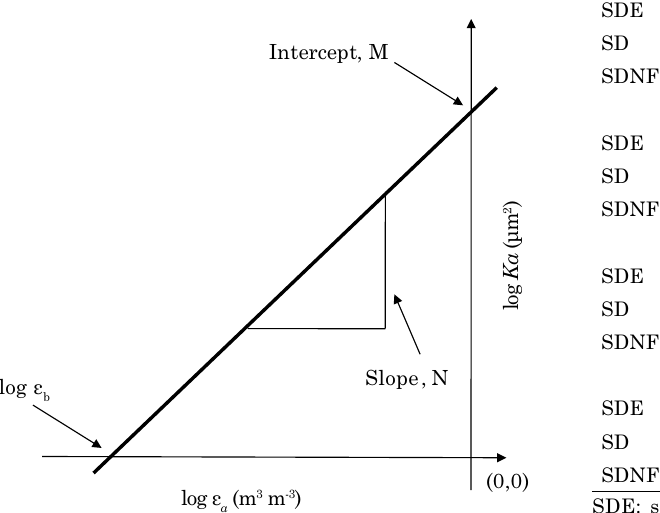
Figura 1. Principais características da relação log (porosidade de aeração, ε a ) - log (permeabilidade ao ar Ka ); slope N, intercepto com o eixo log ( Ka ), M é o limite da porosidade de aeração, ε